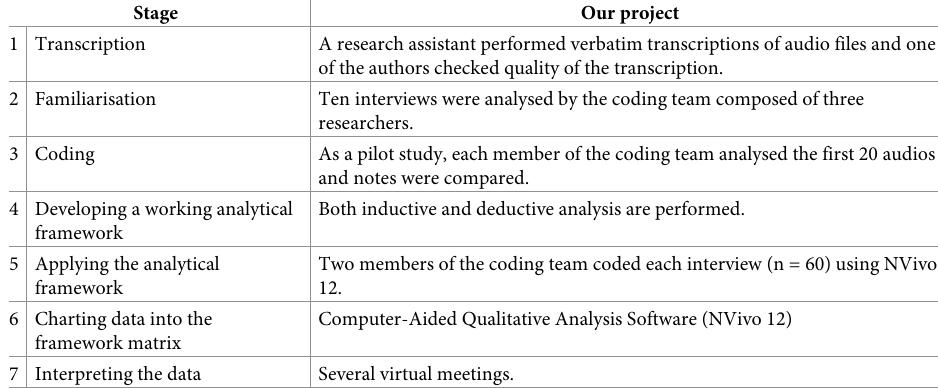
Table 2. Seven stages for analysis using the framework